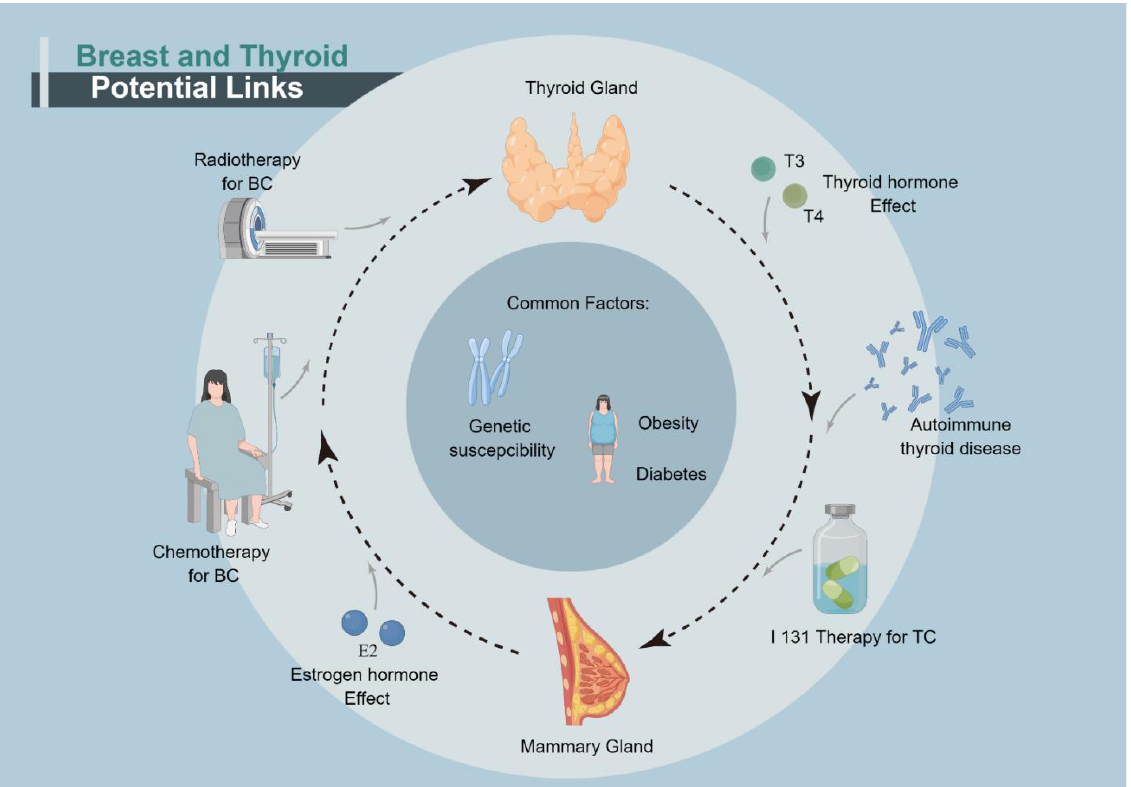
Figure 1. Summary of the potential links of breast and thyroid cancer. Abbreviation: TC: Thyroid Cancer; T3: Triiodothyronine; T4: Thyroxine; BC: Breast Cancer; I 131Therapy: Radioactive iodine therapy.